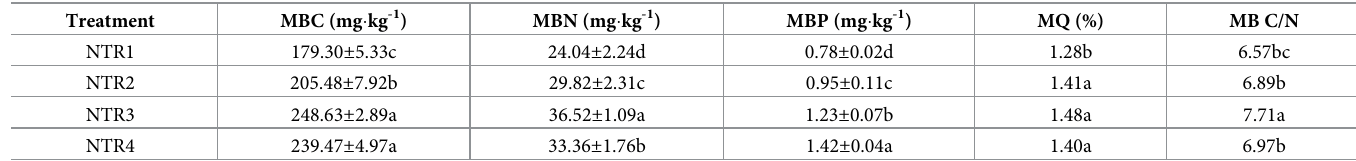
MBC, microbial biomass C; MBN, microbial biomass N; MBP, microbial biomass P; MQ, microbial quotient; MB C/N, microbial biomass C/N. NTR1, no tillage and all crop residue removed; NTR2, no tillage and 30% crop residue mulching; NTR3, no tillage and 60% crop residue mulching; NTR4, no tillage and all crop residue mulching. Values are shown as means ± SD of three biological replicates. Different letters indicate significant differences (ANOVA, P < 0.05, Tukey’s HSD post-hoc